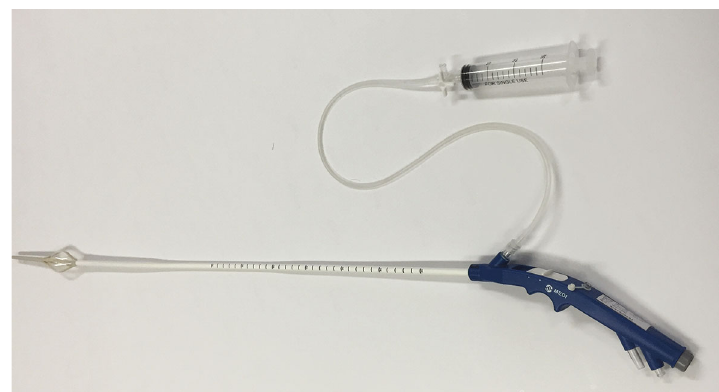
Figure 2: Radiofrequency